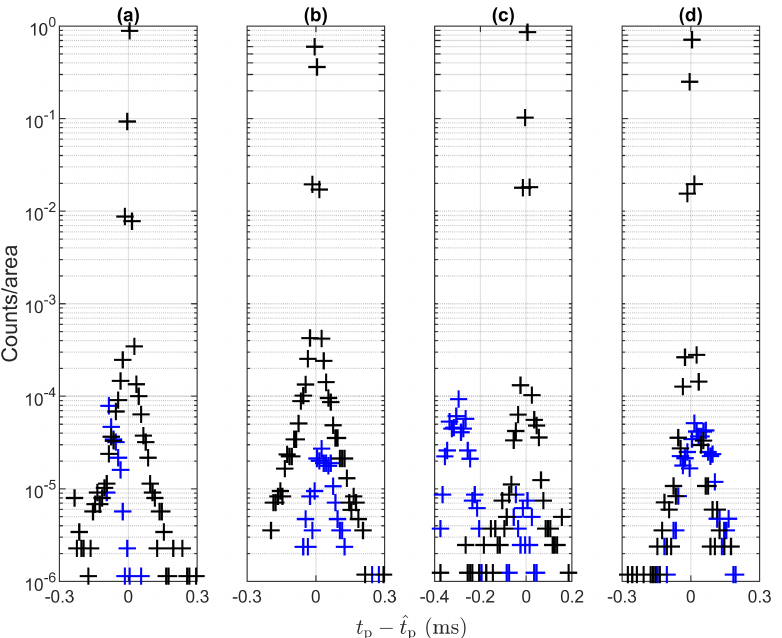
Figure 3. Probability distribution of the packet transmission periods t p measured according the QTP method reported (in log scale) with respect to their nominal values ˆ t p : ( a ) 250, ( b ) 208.3, ( c ) 625, and ( d ) 520.8 µ s. The blue crosses represent the transmission periods between the packets at the turn of the PPS t init , whereas the black crosses are the transmission periods between all other packets. The bin width is 10 µ s.